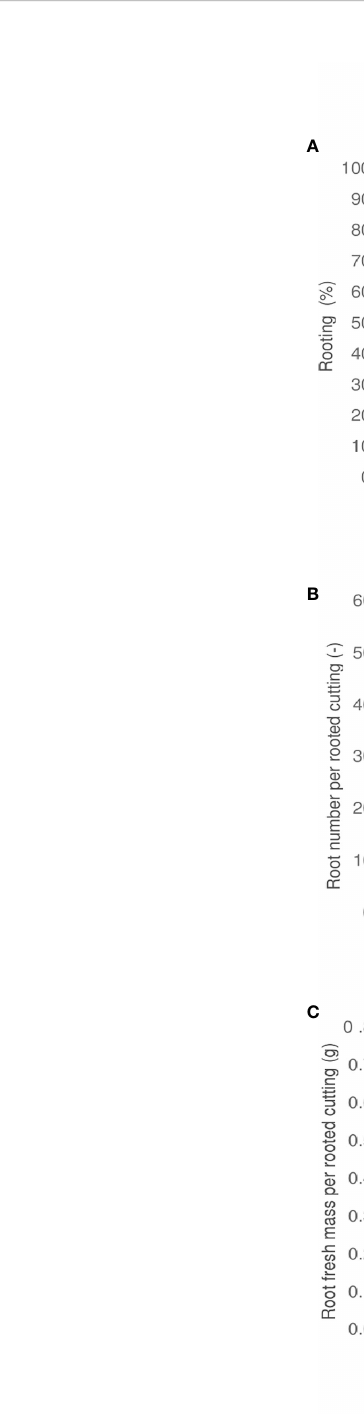
FIGURE 5 AR formation of Rosa ‘ Tan09283 ’ cuttings depending on the treatment (three laser intensities and two laser patterns) in the presence or absence of exogenous IBA (1 mg L -1 ) after 4 weeks of culture. C- control, B- blade (manual) treatment, R- ring pattern, S- strip pattern. (A) Rooting percentage classi fi ed as basal and acrobasal rooting: Number (B) and total root fresh mass (C) per rooted cutting. Mean values and standard errors are shown at treatment level (n = 40). Columns indicated by the same letter, do not represent signi fi cantly different levels (Tukey test, p ≤ 0.05). ns, non-signi fi